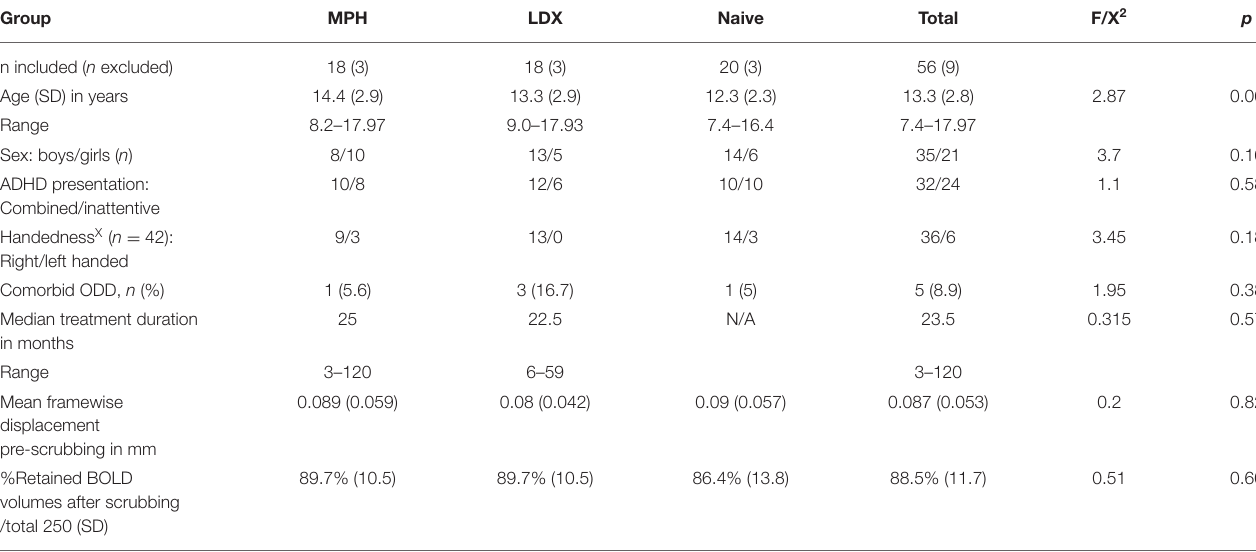
Table of key phenotypic (sociodemographic, clinical) and imaging quality control characteristics across groups, in the sample of participants included in the imaging analyses. Results are means (with standard deviations) except for absolute numbers (n), ranges and proportions (%). Statistical differences among groups are given with their corresponding statistical test value [ANOVA F for comparison of means, Pearson’s Chi-square (X 2 ) for comparison of proportions and Kruskal-Wallis’s Chi-square for comparison of medians] and p-values. P-values are rounded to two decimals. For continuous variables, we conducted descriptive and comparative analyses of means and ranks with both ANOVA and Kruskal-Wallis tests, as the groups were small and heterogeneous. As results were similar, ANOVA results are presented for simplicity. Framewise displacement (FD) measures head motion. Intellectual Quotients (IQ) reported here are for the full-scale. A full table with all the relevant recorded data can be found on Supplementary Material . X Variables with missing data. MPH, group 1, on methylphenidate; LDX, group 2, on lisdexamfetamine; ADHD, Attention-deficit/hyperactivity disorder; 15q, Edinburgh Handedness Questionnaire, 15-item version; ADHD-RS.es, ADHD rating scale, Spanish version; ODD, oppositional-defiant disorder; N/A, not applicable; SD, standard